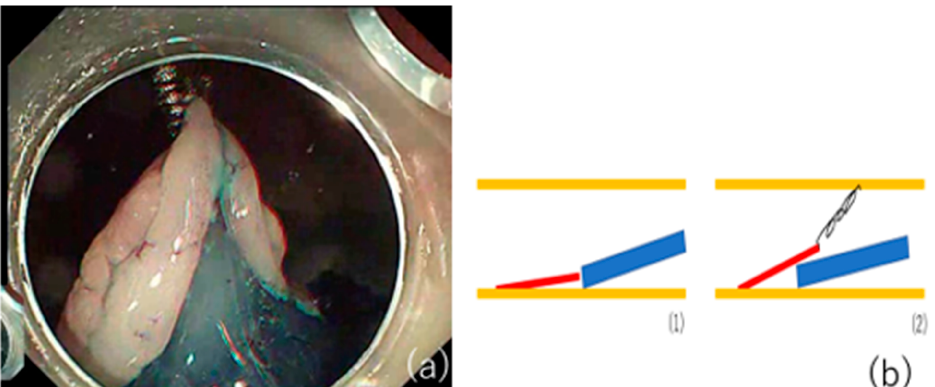
Figure 1. Usefullness of a S-O clip. ( a ) Good traction is obtained by using the S-O clip. ( b ) (1) Without S-O clip. It is difficult to go into the submucosal layer. (2) The submucosal layer can be easily visualized by applying the S-O clip at a site 2-fold distant from the anal side of the lesion.